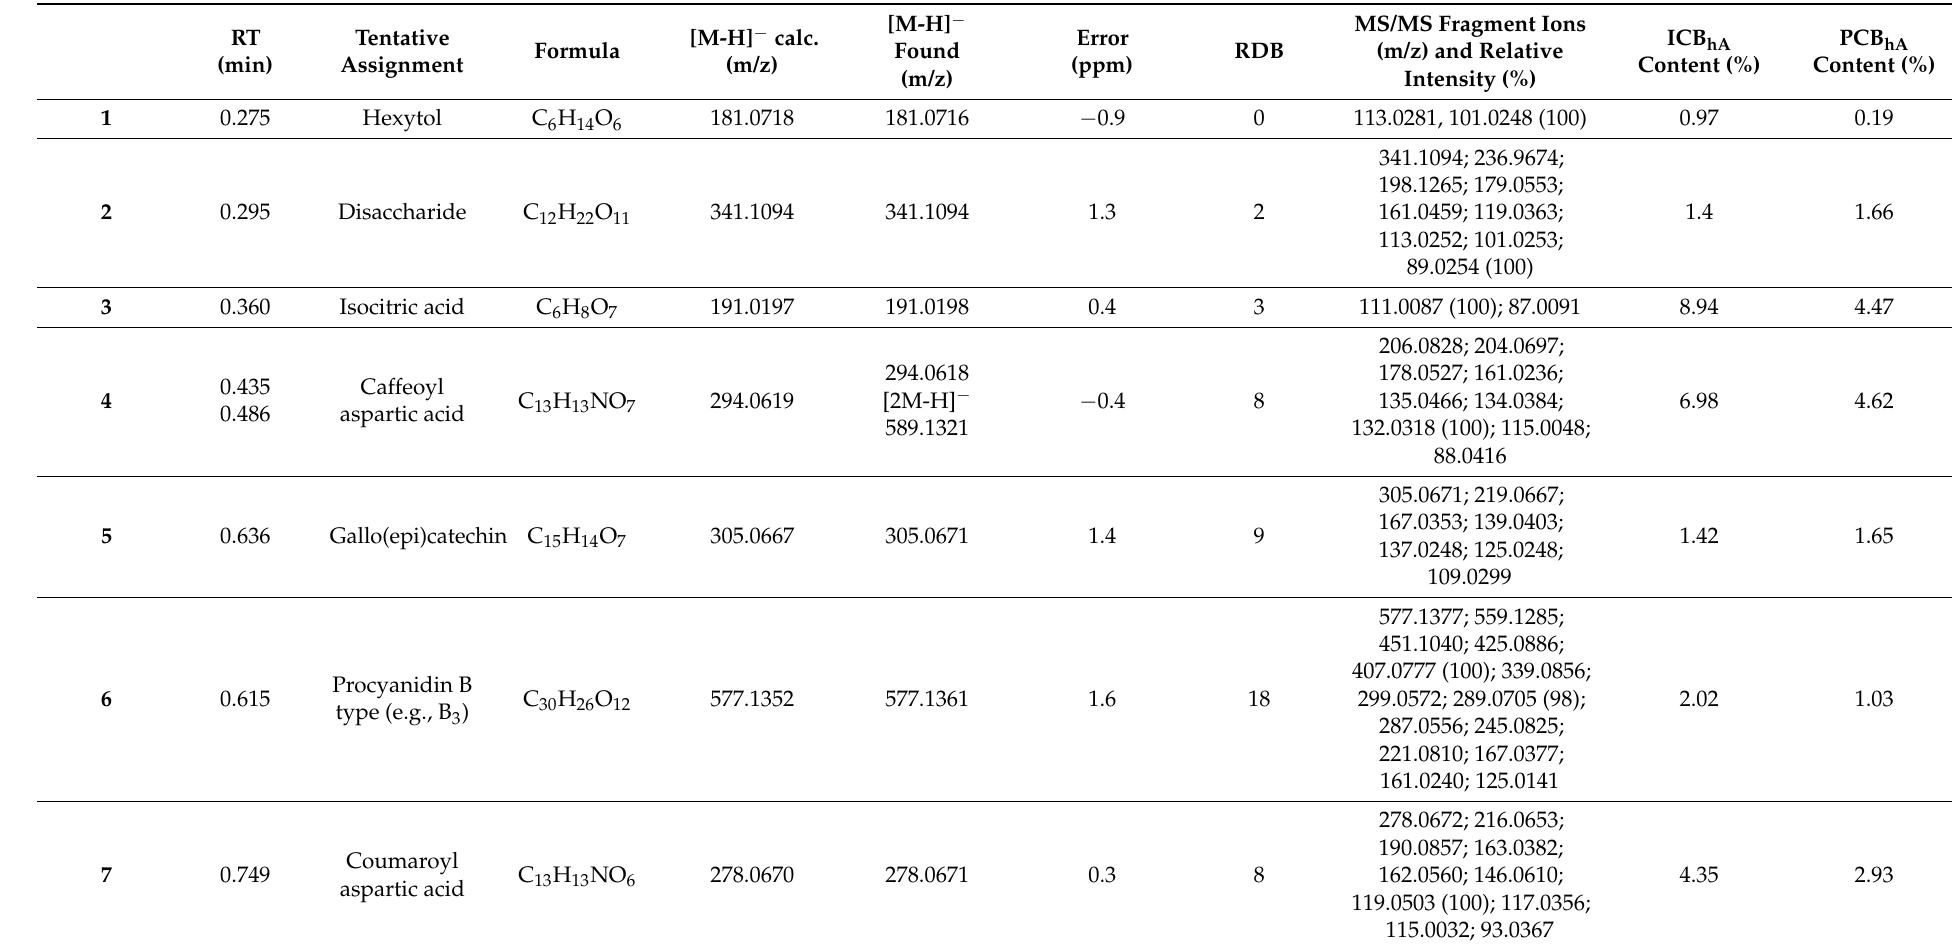
Table 5. Time-of-flight mass spectrometry (TOF-MS) and TOF-MS/MS. TOF-MS and TOF-MS/MS of tentatively identified metabolites. RT = Retention Time; RDB = Ring Double Bond equivalent